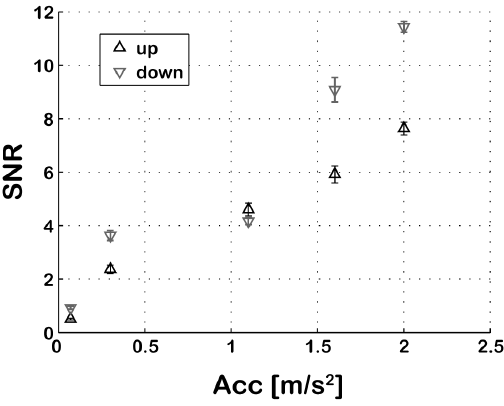
Figure 4. SNRs for motion profiles. The SNR for upward and downward motion profiles increases as a function of motion intensity. Error bars represent standard deviations of the 20 repetitions of each